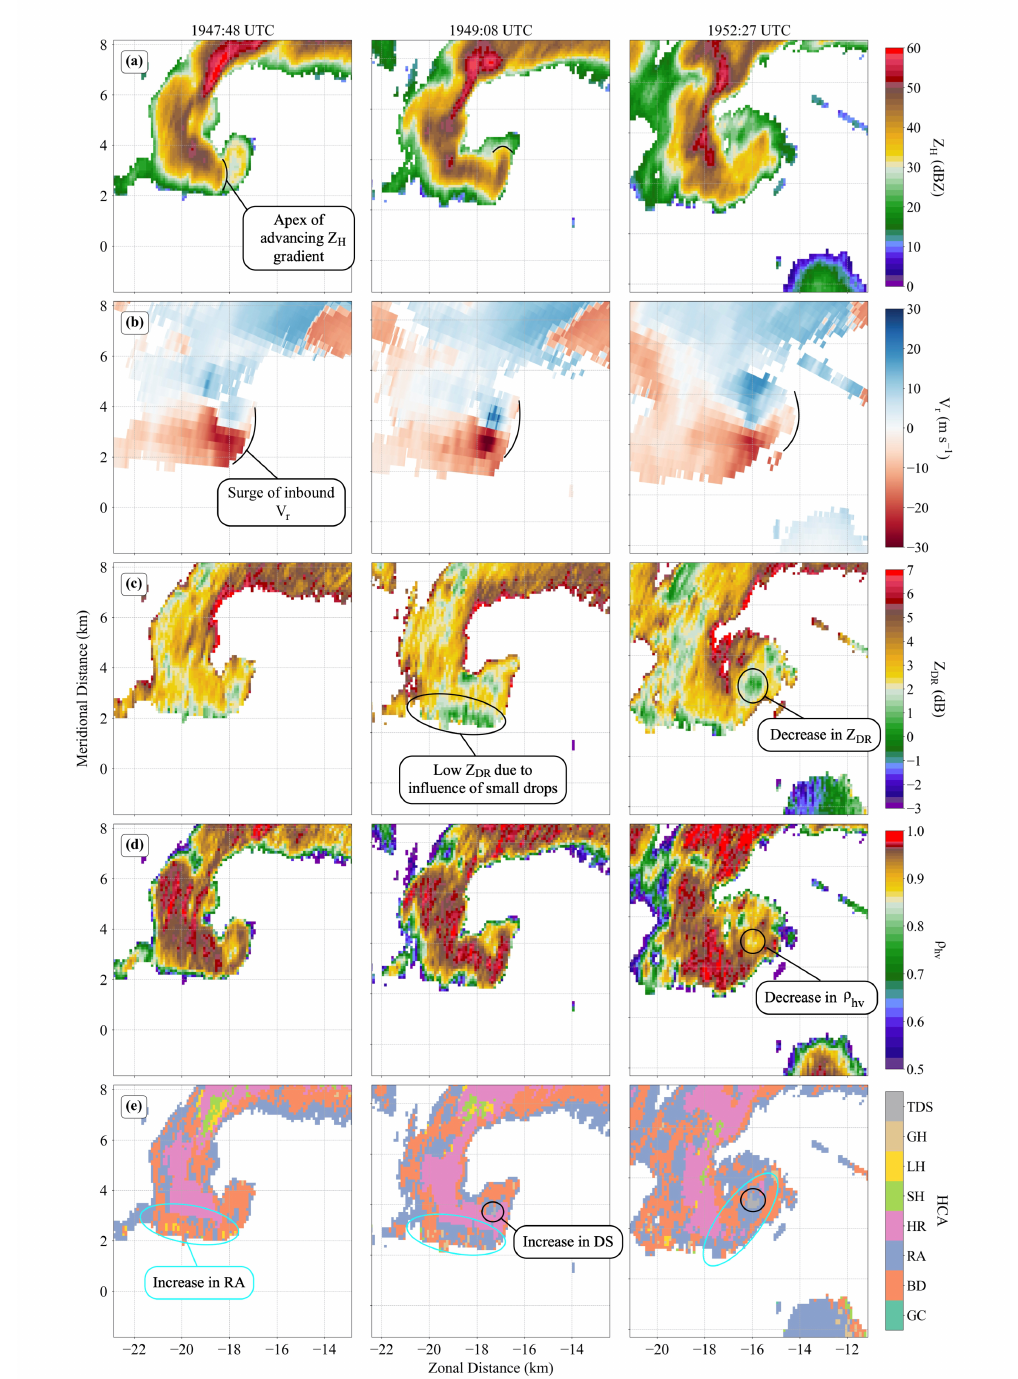
Figure 6. From top to bottom row ( a – e ): Z H , Doppler velocity ( V r ), differential reflectivity ( Z DR ), correlation coefficient ( ρ hv ), and HCA from PX-1000 for three subsequent times—from the left to right column, 1947:48, 1949:08, and 1952:27 UTC—highlighting surge A. Annotations detail polarimetric characteristics associated with the evolution of the momentum